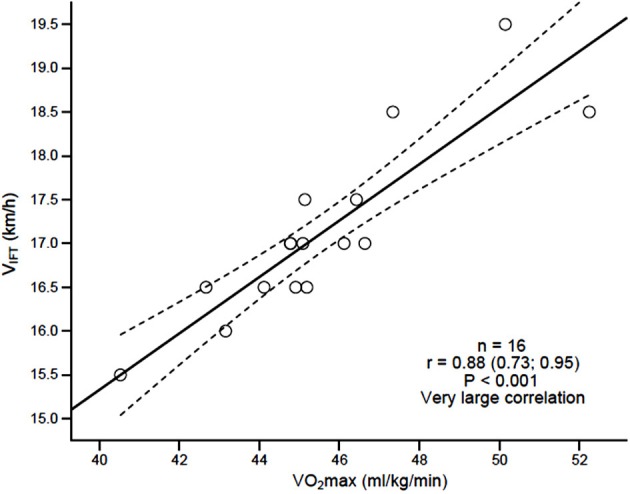
Linear dependence of estimated maximal oxygen consumption (VO2max) based on 30–15IFT end speed (VIFT).